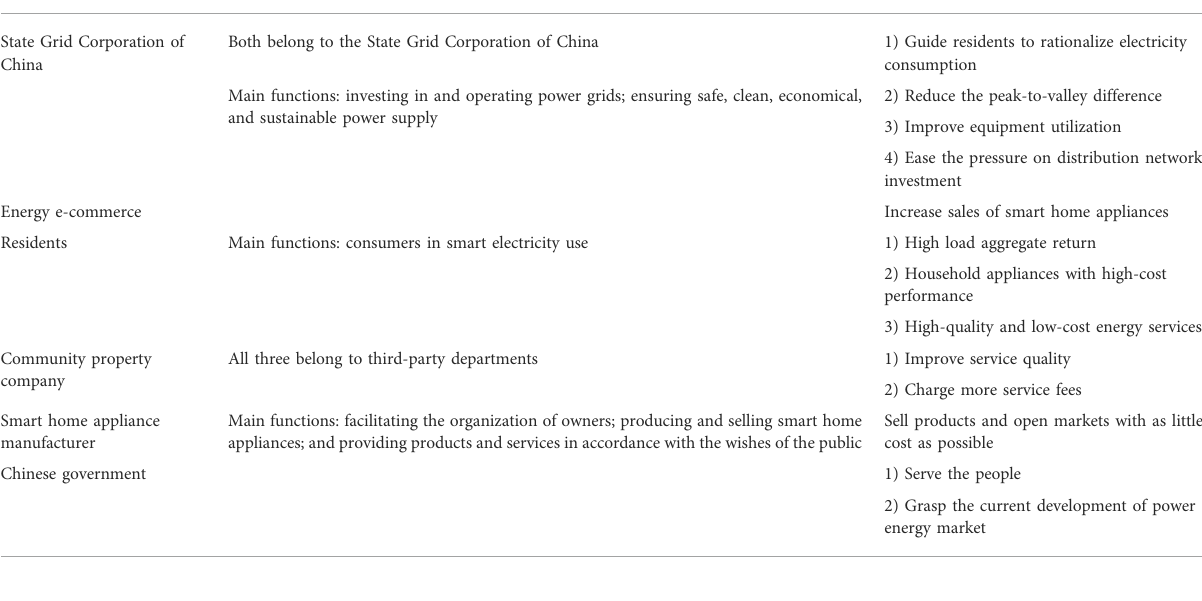
TABLE 1 Market position and interest demand of agent.